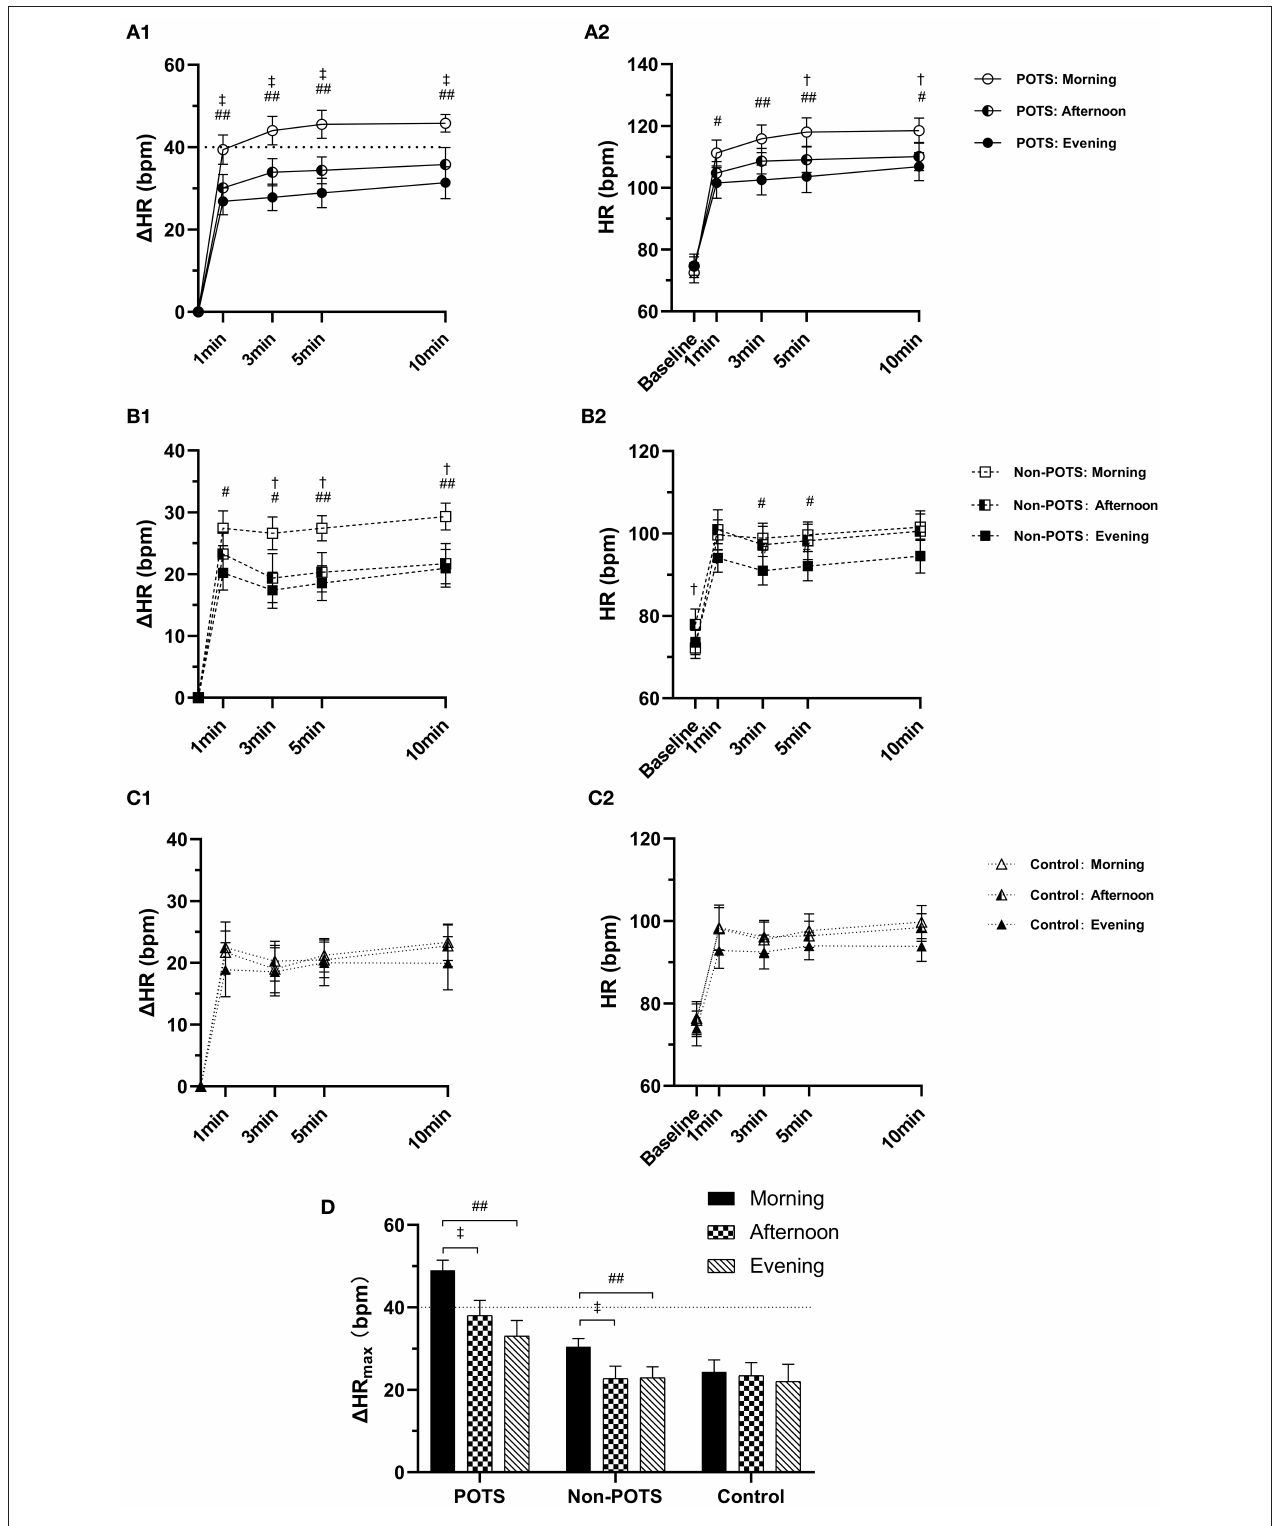
FIGURE 1 | Diurnal variability in orthostatic parameters of HR among the POTS, non-POTS, and control groups. (A1, B1, C1) The heart rate change from supine to standing ( 1 HR) at 1, 3, 5, and 10min in the POTS, non-POTS, and control groups, respectively. (A2, B2, C2) Absolute HR at baseline and 1, 3, 5, and 10min after standing in the POTS, non-POTS, and control groups, respectively. (D) The maximum HR increment ( 1 HRmax) during the 10-min standing test in the POTS, non-POTS, and control groups. Data are mean ± 95% CI. After Bonferroni test, † P < 0.05, ‡ P < 0.001 significant difference compared with that measured in the afternoon test.# P < 0.05, ## P < 0.001 significant difference compared with that measured in the evening test ( P < 0.05).